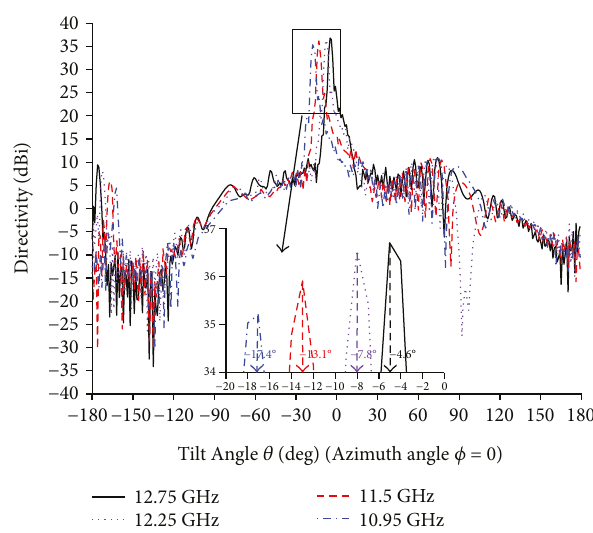
Figure 6: The full-wave simulation patterns of 700mm circular- aperture antenna model when relative rotation between CTS layer and SWS is zero.